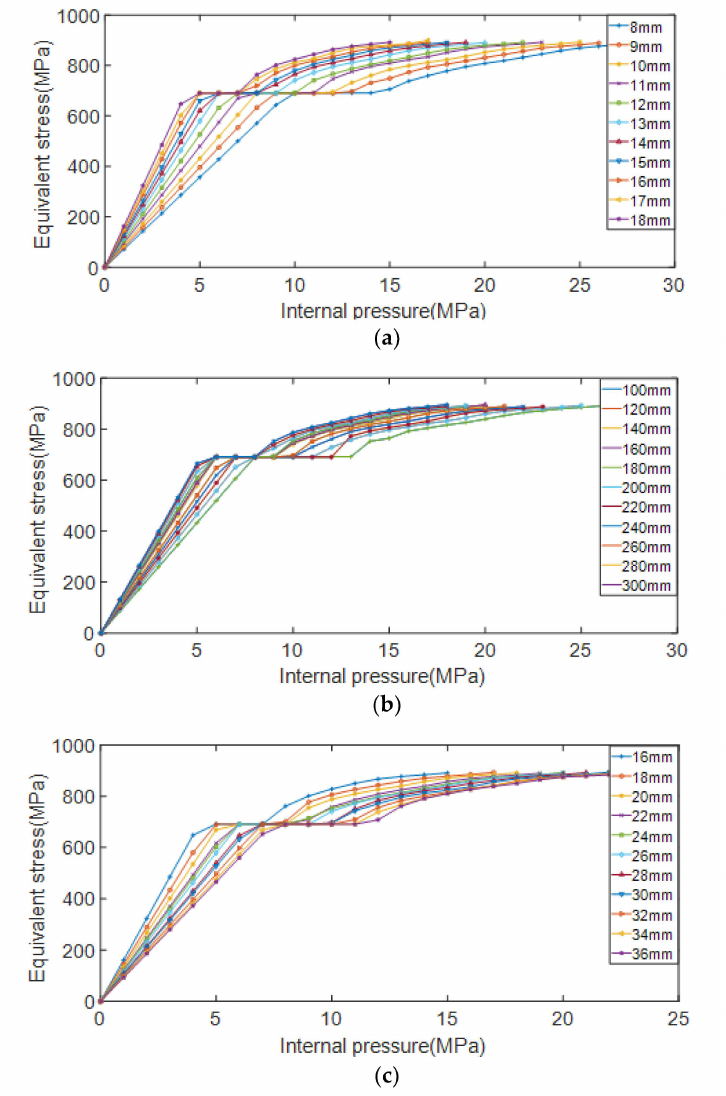
Figure 14. Variation of equivalent stress with internal pressure load under different defect conditions.